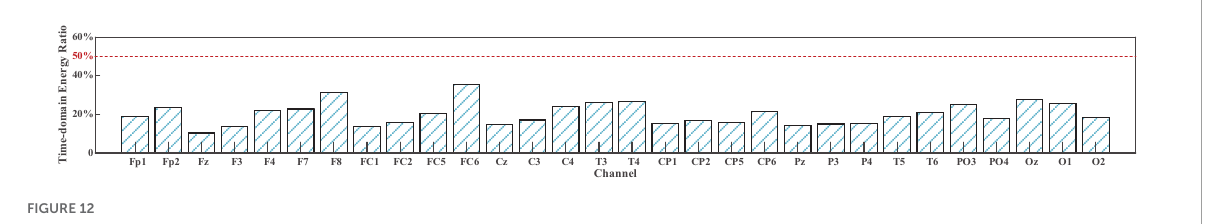
FIGURE12 The decreased ratio of temporal energy in (5Hz, 95Hz) slight-facial expression (sFE)-electroencephalograms (EEG) after discarding the electromyogram (EMG) component.